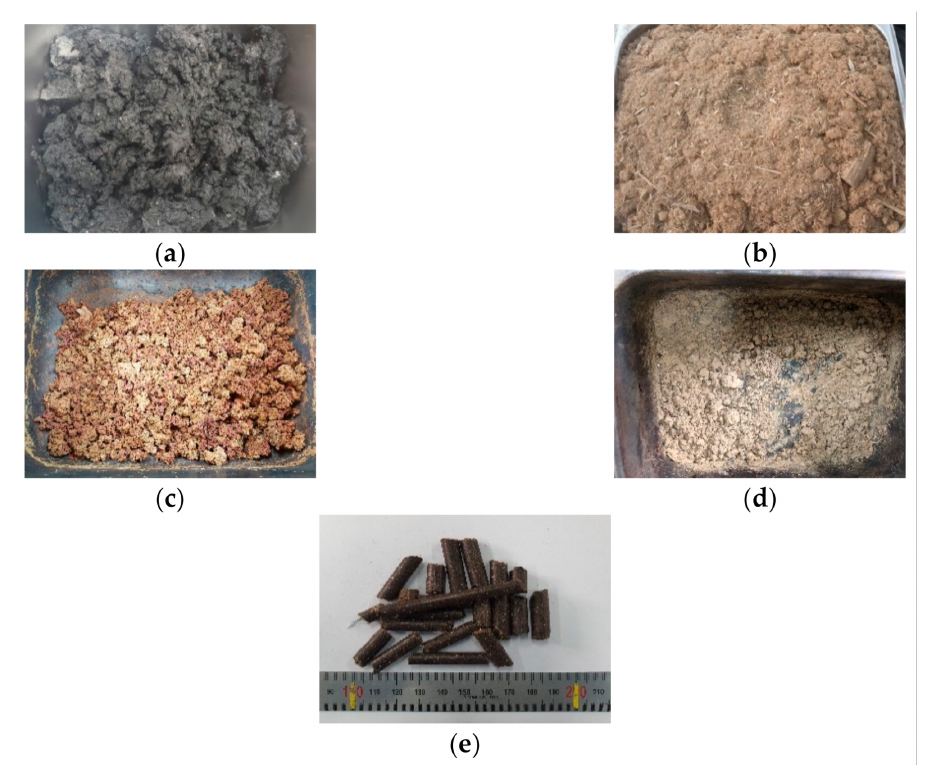
Figure 3. Images of samples: ( a ) sewage sludge, ( b ) sawdust, ( c ) sewage sludge ash, ( d ) sawdust ash, and ( e ) sewage sludge solid fuel